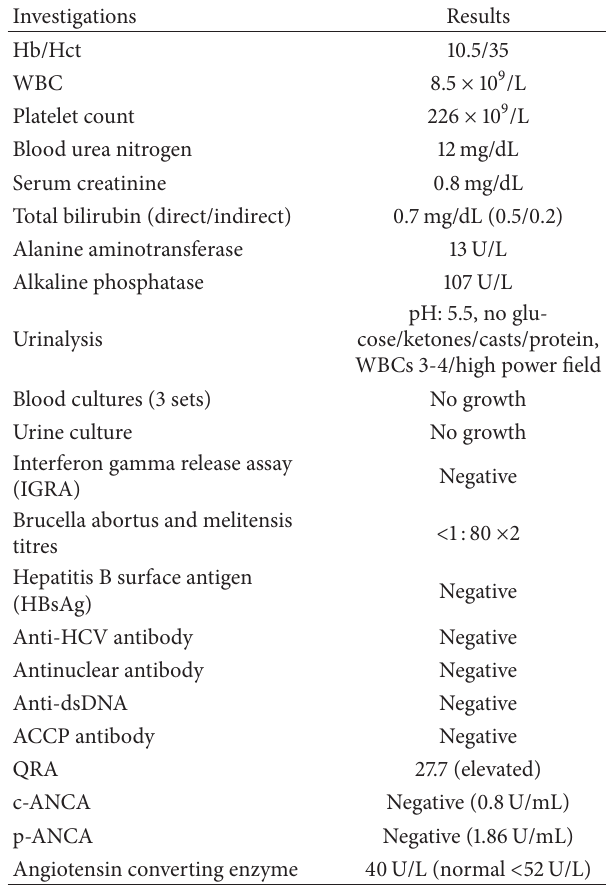
Table 1: Laboratory